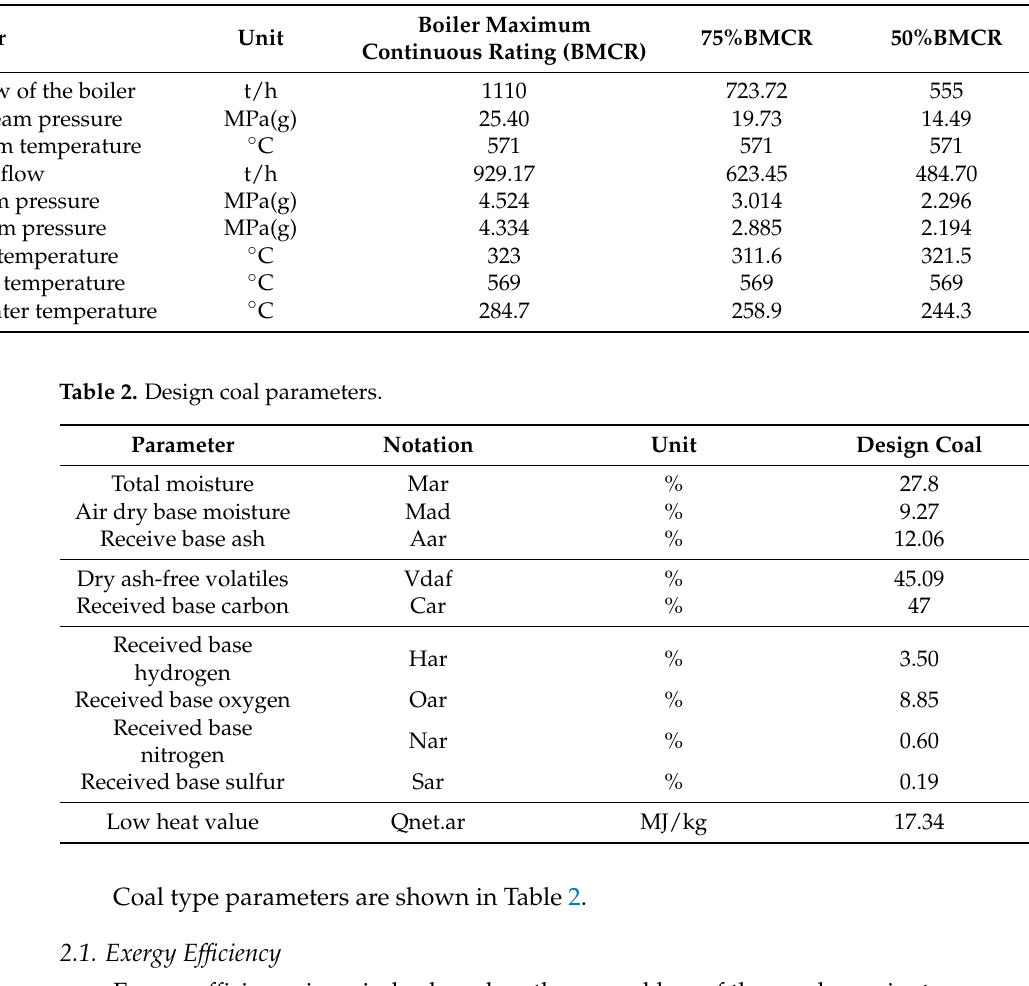
Table 1. Main parameters of boiler.